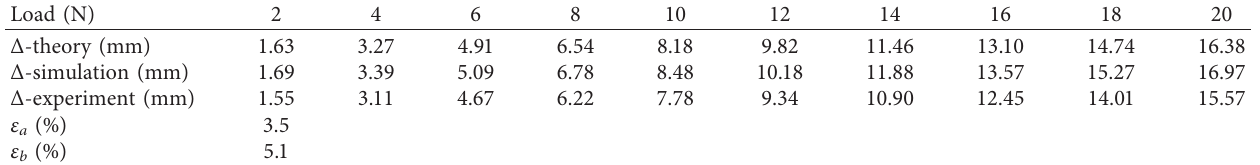
Table 5: Comparison of displacement in the x -axis of TLET: theory, simulation, and experiment.